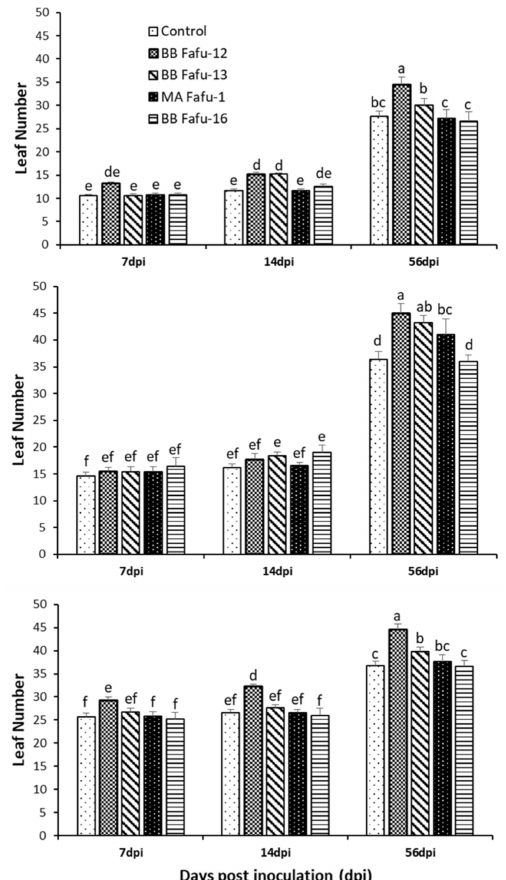
Figure 3. Mean ( ± SE) leaf number of citrus seedlings at 7, 14, and 56 days post-inoculation (dpi) with entomopathogenic fungal strains (BB Fafu-12, BB Fafu-13, MA Fafu-1, and BB Fafu-16) or sterile distilled water containing 0.1% Tween 80 (Control). ( A – C ) are showing the mean leaf number of citrus seedlings treated at 3, 4, and 6 months post-planting, respectively. Bars ( ± SE) with di ff erent letters indicate significant di ff erences among treatments at p < 0.05. (LSD after a two-way